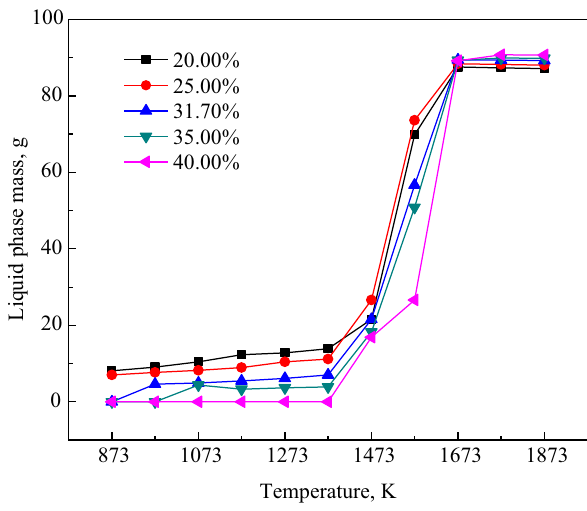
Figure 9: Relationship between liquid production and temperature under di ff erent CaO contents.